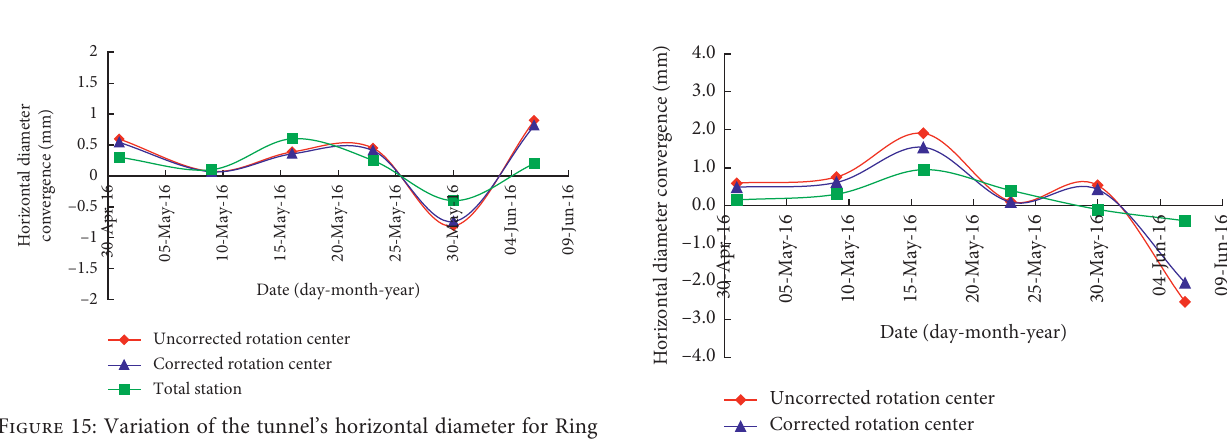
Figure 14: Installation process of inclinometer modules: (a) impact drilling, (b) insertion of the chemical bolts into the holes, and (c) fixing of the inclinometer modules.